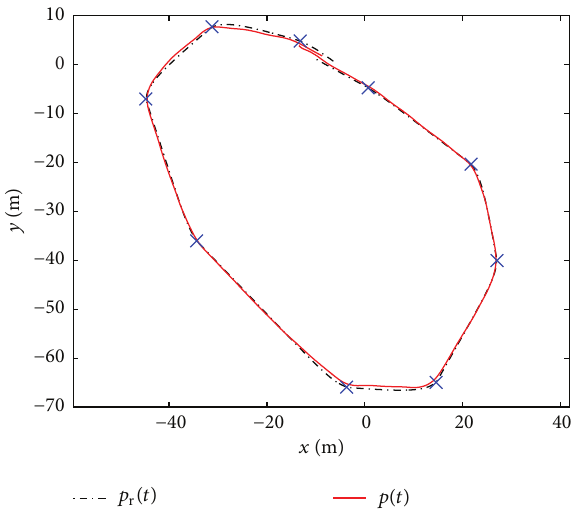
Figure 16: Tracking performance at 9 m / s. The crosses are desired